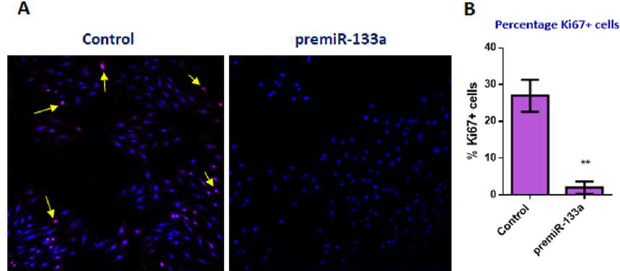
Figure 5. Effect of miR-133a on cellular proliferation in cardiomyocytes. Immunohistochemistry for Ki67 positive cells (arrows) and staining with DAPI (blue) in control cardiomyocytes obtained from H9c2 cell culture and subjected to premiR-133a treatment ( A ). Note that the percentage of Ki67 positive cells is dramatically repressed in premiR-133a treated cardiomyocytes ( B ). Student’s t -test: ** p < 0.01.